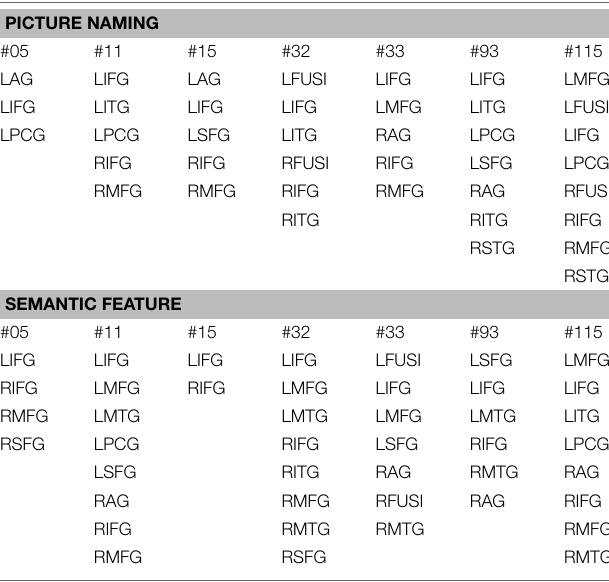
TABLE 8 | Regions of interest for patients (active at both pre and post-rehabilitation) selected for DCM analysis for the picture naming task and semantic feature